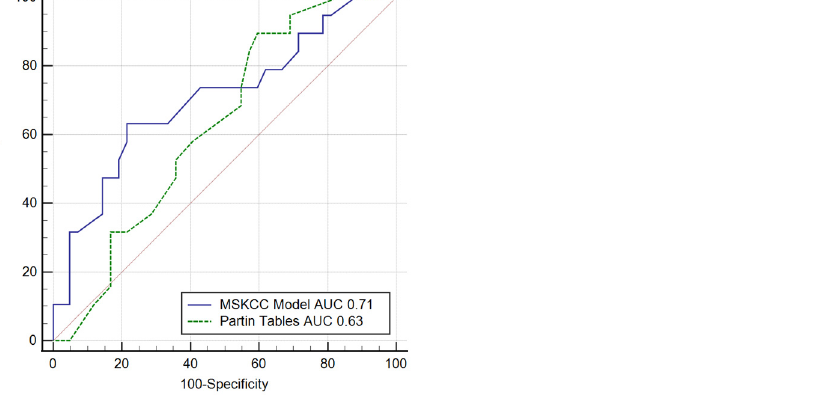
Figure 3. ROCs for MSKCC and Partin Tables for EPE. ROC—receiver operating curve; AUC—area under the curve; MSKCC—Memorial Sloan-Kettering Cancer Center nomogram; EPE—extraprostatic extension; p = 0.211; ∆ AUC = 0.08.